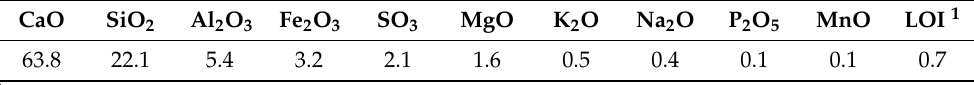
Table 1. Chemical composition (wt.%) of OPC as determined by X-ray fluorescence